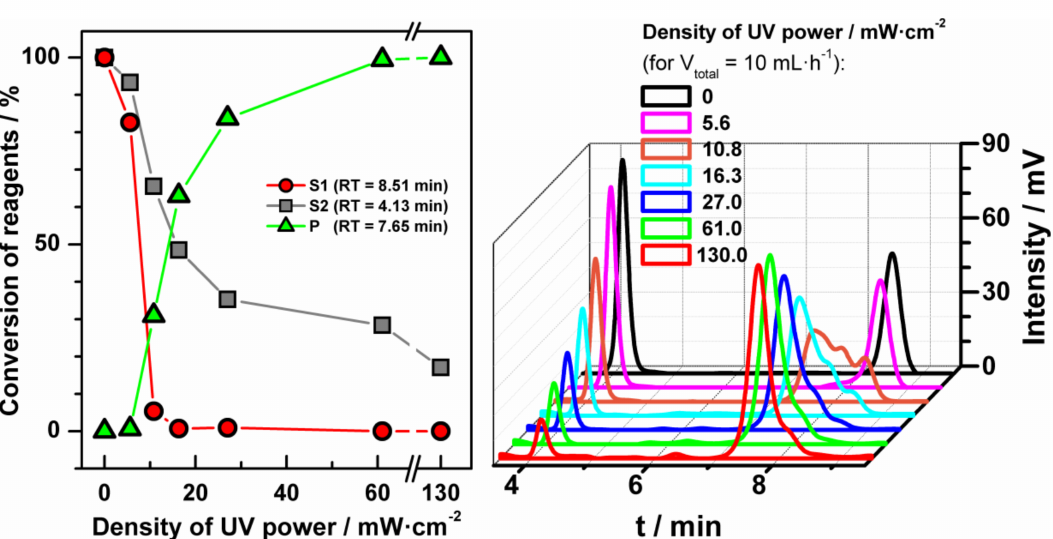
Figure 6. Conversion of reagents of the thiol-ene ‘click’ reaction in acetonitrile in the function of power of UV lamp and the corresponding HPLC chromatogram. Substrates were 2,4,6-triallyloxy-1,3,5-triazine ( 4 ) and, in excess, methyl mercaptoacetate ( 5 ). Reaction occurred at room temperature and yield receiving the product ( 7